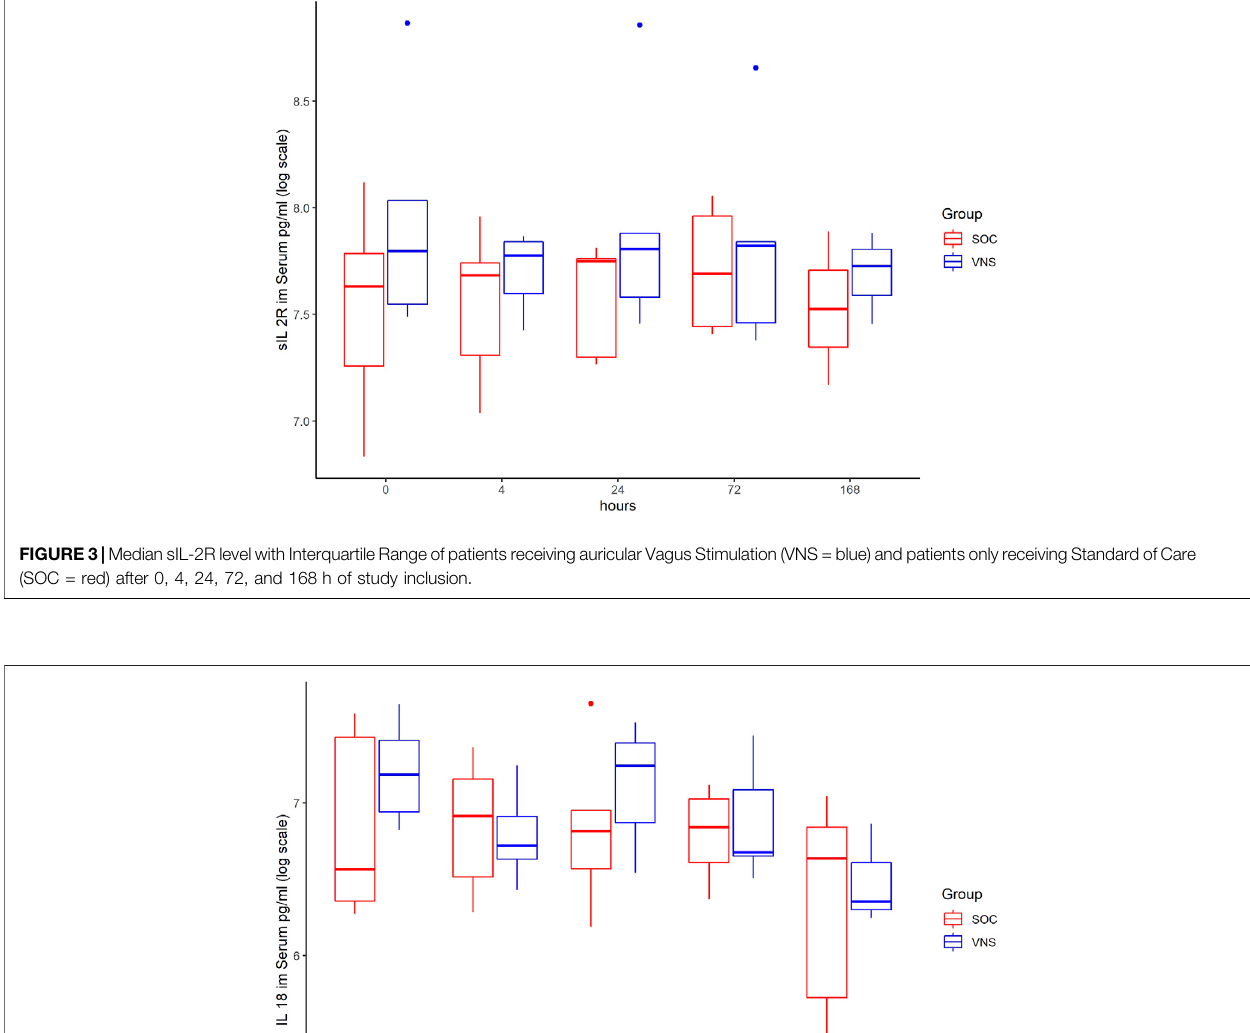
Frontiers in Physiology |